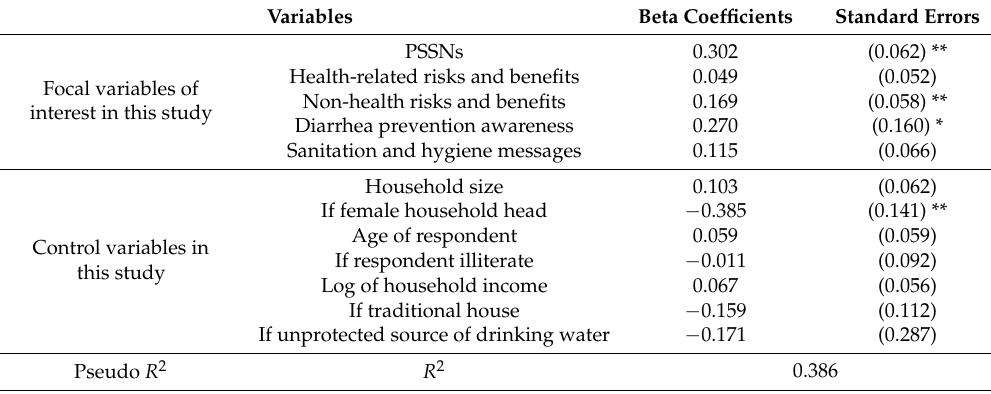
Table A2. Predictors of sanitation safety (full-specification of main effect model; i.e., including regression estimates for control variables).